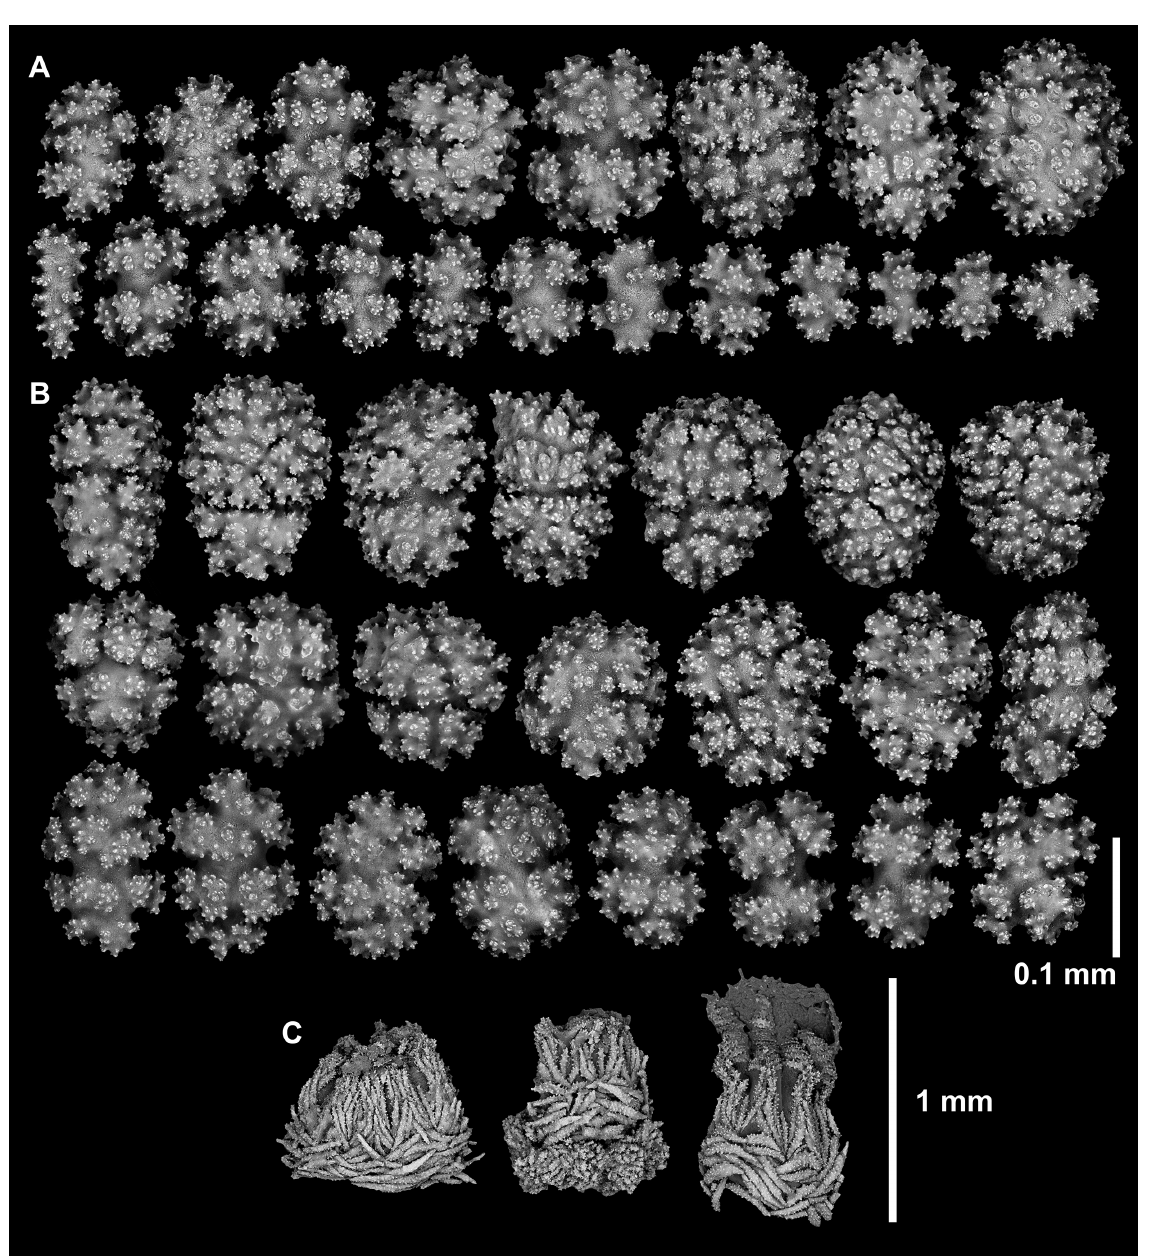
Fig. 23. Kotatea niwa gen. et sp. nov., holotype (MAGNT C015226), SEMs of sclerites. A . Base surface. B . Base interior. C . Polyps (in